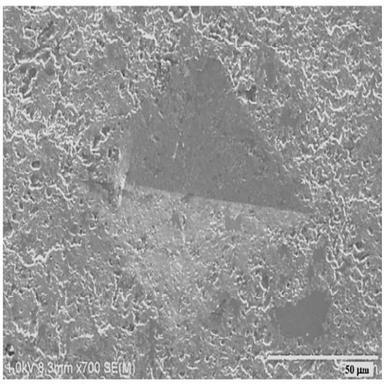
FE-SEM micrograph of indent after sintering at 1800°С.